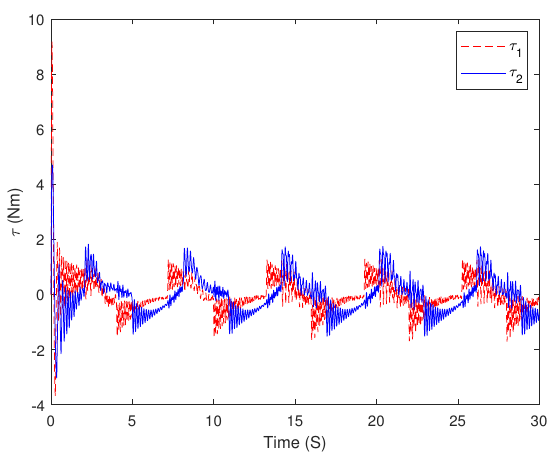
Figure 5. The proposed adaptive robust admittance controller in